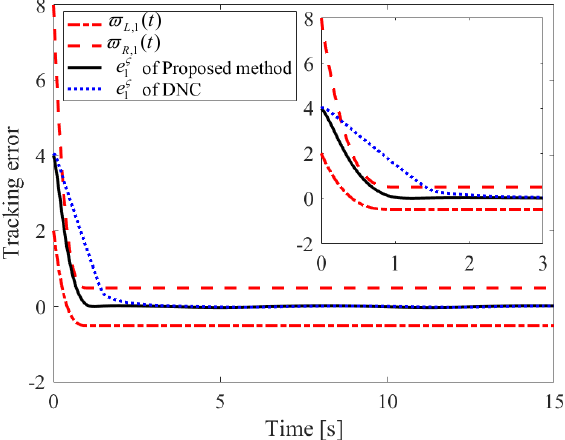
Figure 4. Convergence performance of e ς